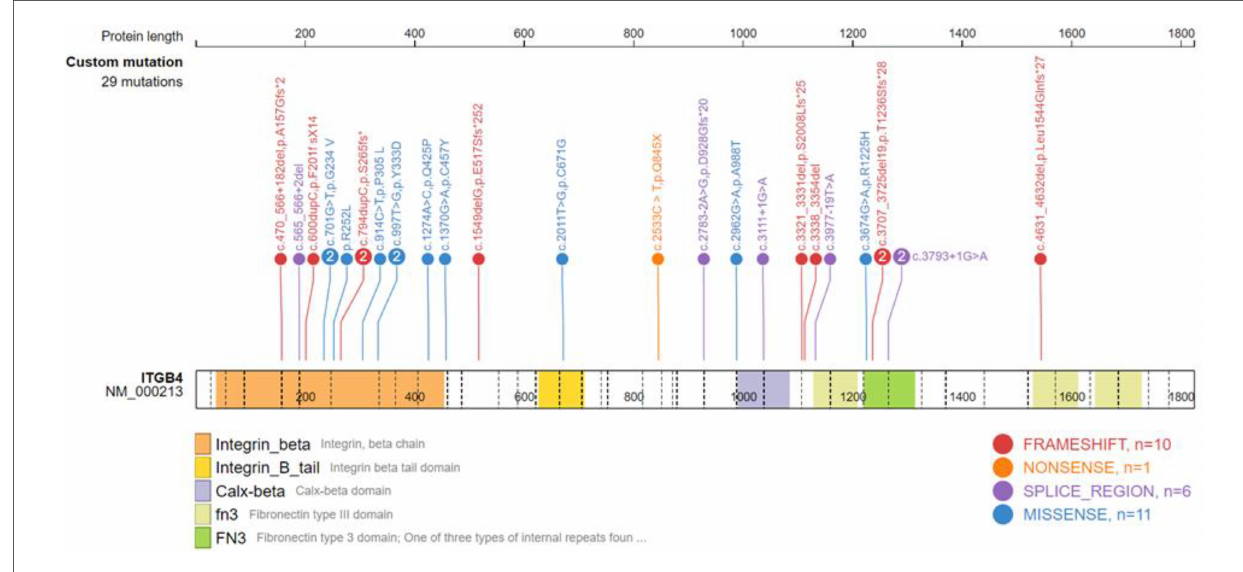
FIGURE 4 Schematic diagram of the ITGB4 domain and the location of the ITGB4 mutation.